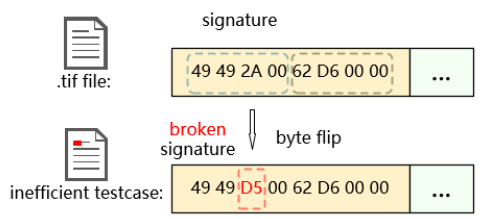
Figure 2. Example of an inefficient .tif test case due to blind mutations.